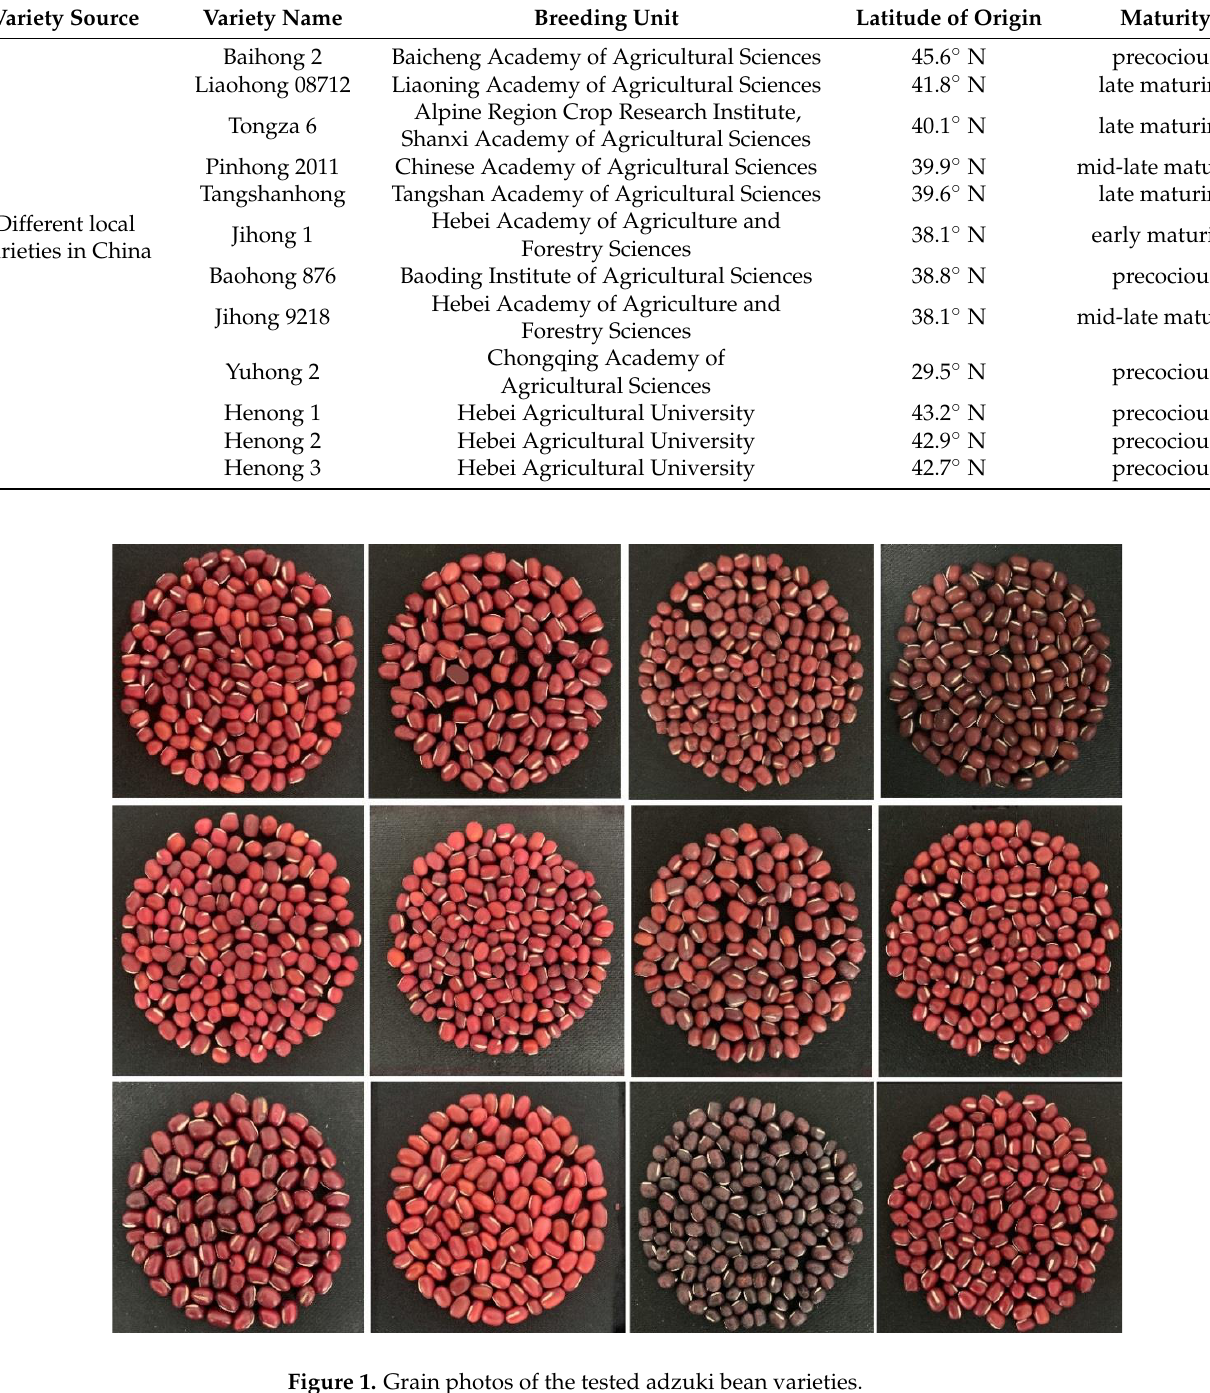
Table 1. Source and maturity of different adzuki bean varieties.